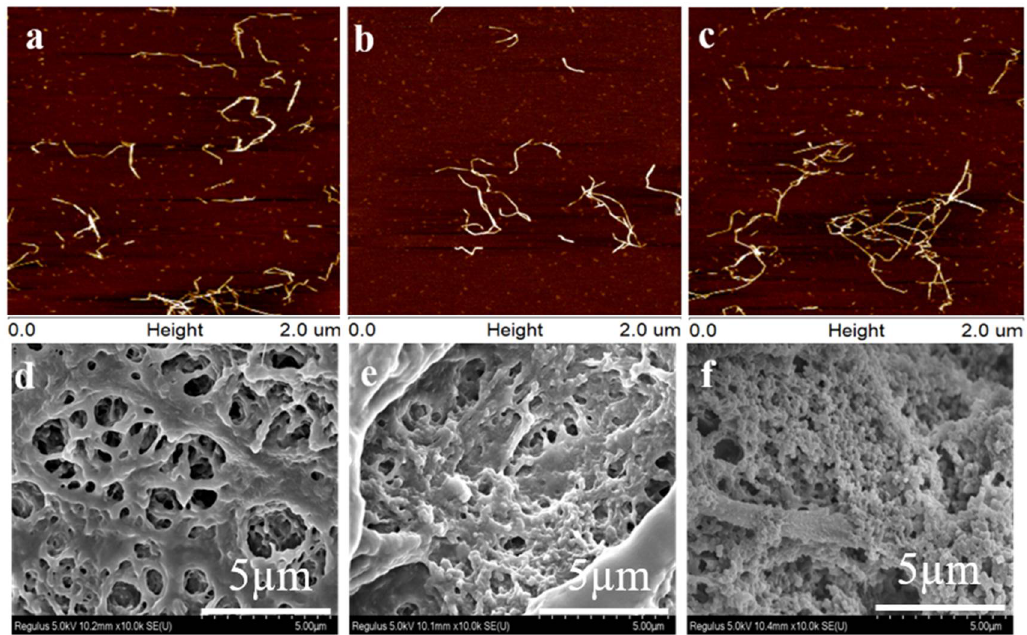
Figure 2. AFM images for dispersions of ( a ) CMCNF10, ( b ) CMCNF20, ( c ) CMCNF30; SEM images for aerogel of ( d ) CMCNF10-PEI, ( e ) CMCNF20-PEI, ( f ) CMCNF30-PEI. A total of 0.03 g of CMCNF30 aerogel obtained by freeze drying of CMCNF30 sus- pension was weighed and placed into 20 mL of deionized water for a hydrophilicity test. As shown in Figure 3, from the appearance, the color of CMCNF30 aerogel is white. After PEI modification, the color of CMCNF30/PEI aerogel turned yellow due to Schiff base reaction. CMCNF30/PEI aerogel of the same quality was used for comparison. The volume of both CMCNF30 and CMCNF30/PEI aerogels increased due to water absorption one minute after the aerogels were placed in deionized water. After 12 h, CMCNF30 aerogel dissolved in water, however, CMCNF30/PEI aerogel did not changed. This proves that the hydrophilicity of CMCNF decreases after PEI modification.